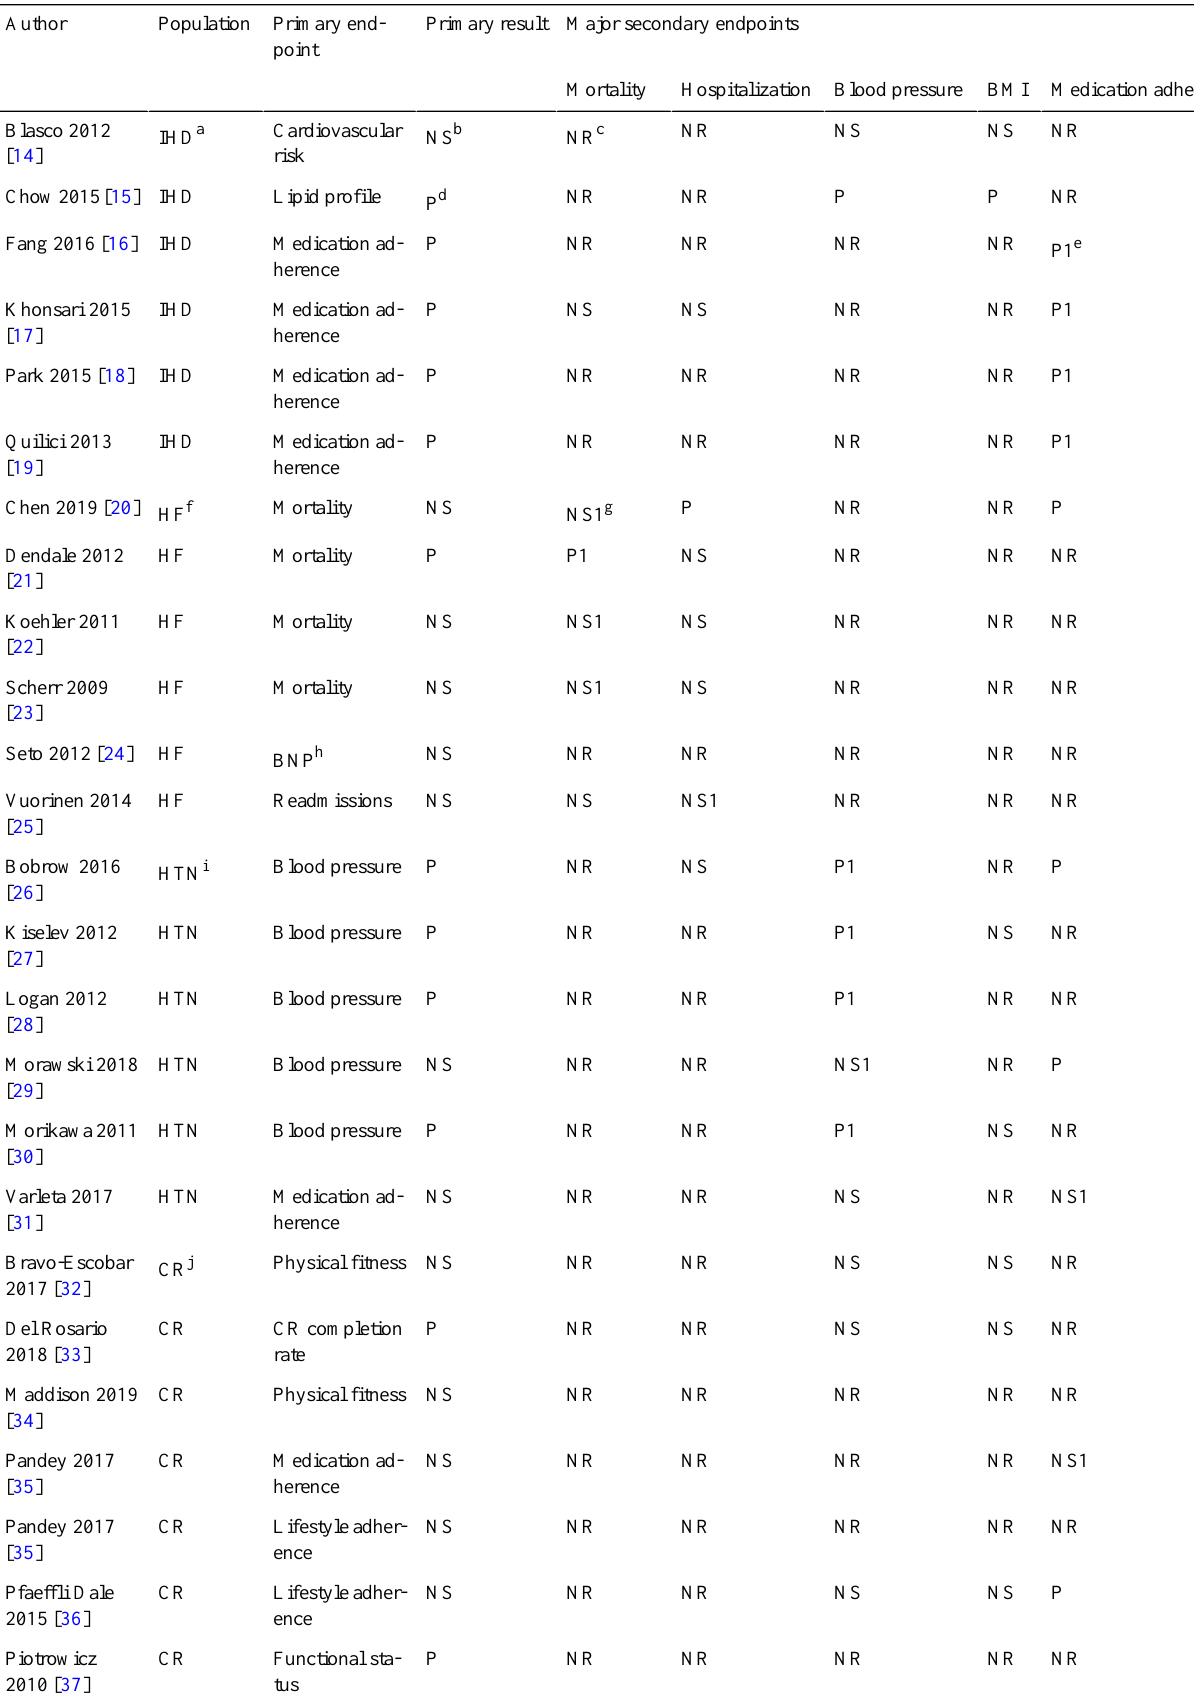
Table 2. Endpoints examined in randomized trials of mobile phone technology in cardiovascular